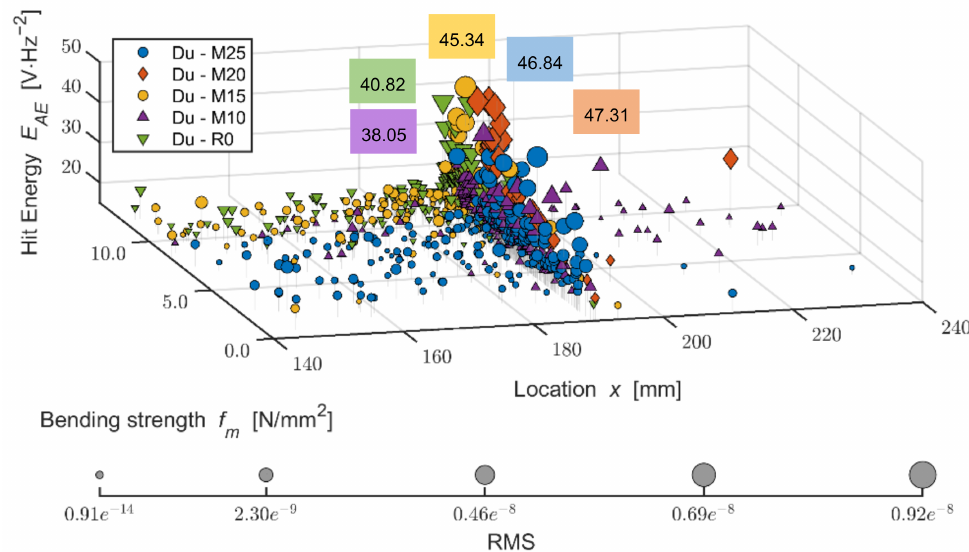
Figure 20. Comparison of bending strength and defect development (hit energy with maximum; larger points = higher RMS) during static mechanical load in the monitored area of the test specimens; mixture DU (boards modified by dust DU) before and after frost/defrost cycles. x = 190 mm—middle of the